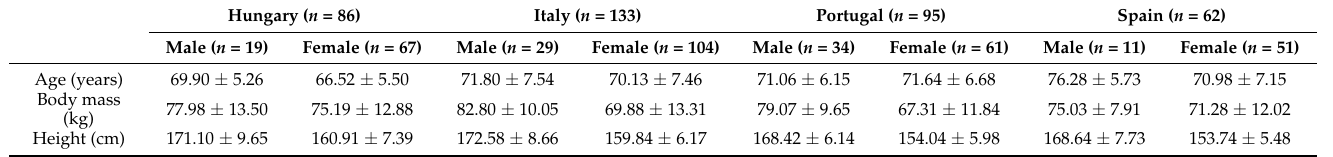
Table 1. Mean ± SD values of age, body mass, and height of the sample regarding age and sex for each county. Hungary ( n = 86) Italy ( n = 133) Portugal ( n = 95) Spain ( n = 62) Male ( n = 19) Female ( n = 67) Male ( n = 29) Female ( n = 104) Male ( n = 34) Female ( n = 61) Male ( n = 11) Female ( n = 51) Age (years) 69.90 ± 5.26 66.52 ± 5.50 71.80 ± 7.54 70.13 ± 7.46 71.06 ± 6.15 ± 13.50 75.19 ± 12.88 82.80 ± 10.05 (kg) 77.98 Height (cm) 171.10 ± 9.65 160.91 ± 7.39 172.58 ± 8.66 159.84 ±